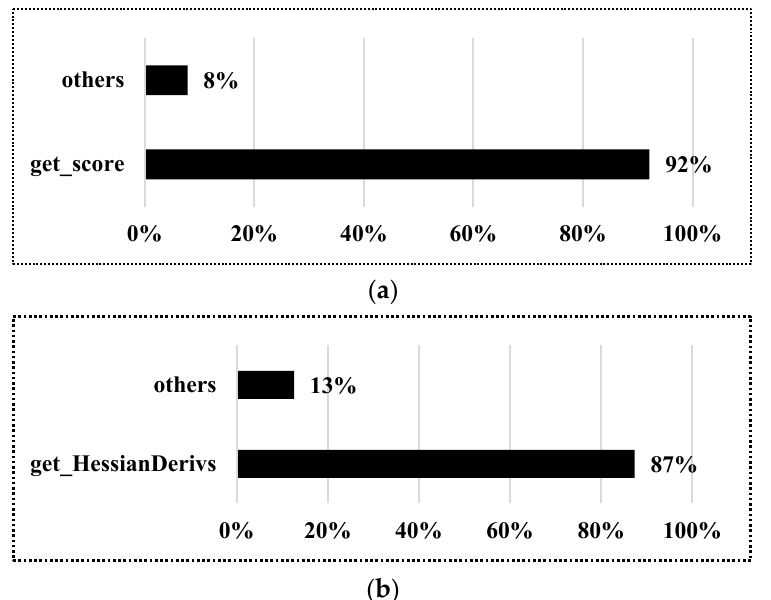
Figure 7. Computational load analysis of major tasks in the NLO-CSM algorithm in: ( a ) coarse match process; ( b ) fine match process.